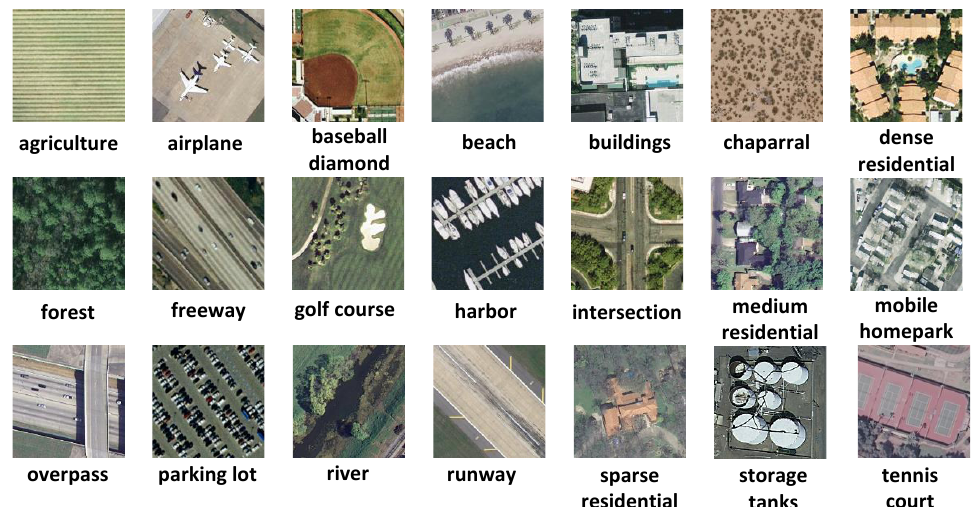
Figure 7. Examples of different categories in the UCM dataset.